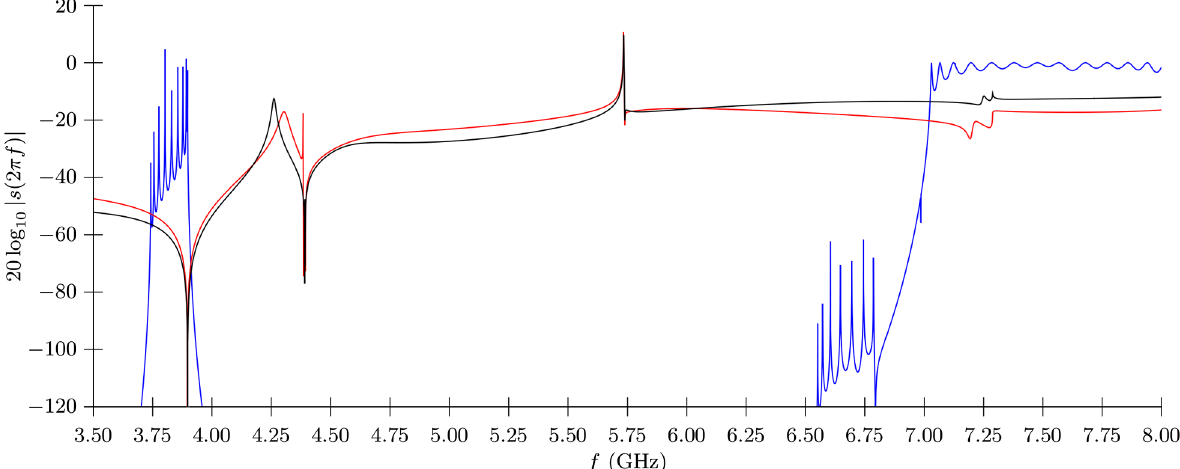
FIG. 5. Three examples of numerically computed transmissions. Blue: Transmission from left to right TM 01 port mode of third harmonic cavity (CSC segment 2). Red: Transmission of one-leg HOM coupler (CSC segment 1) from coaxial HOM port (TEM mode) to the beam pipe (TM 01 mode) next to the cavity. Black: Transmission of two-leg HOM coupler (CSC segment 6) from coaxial HOM port (TEM mode) to the beam pipe (TM 01 mode) next to